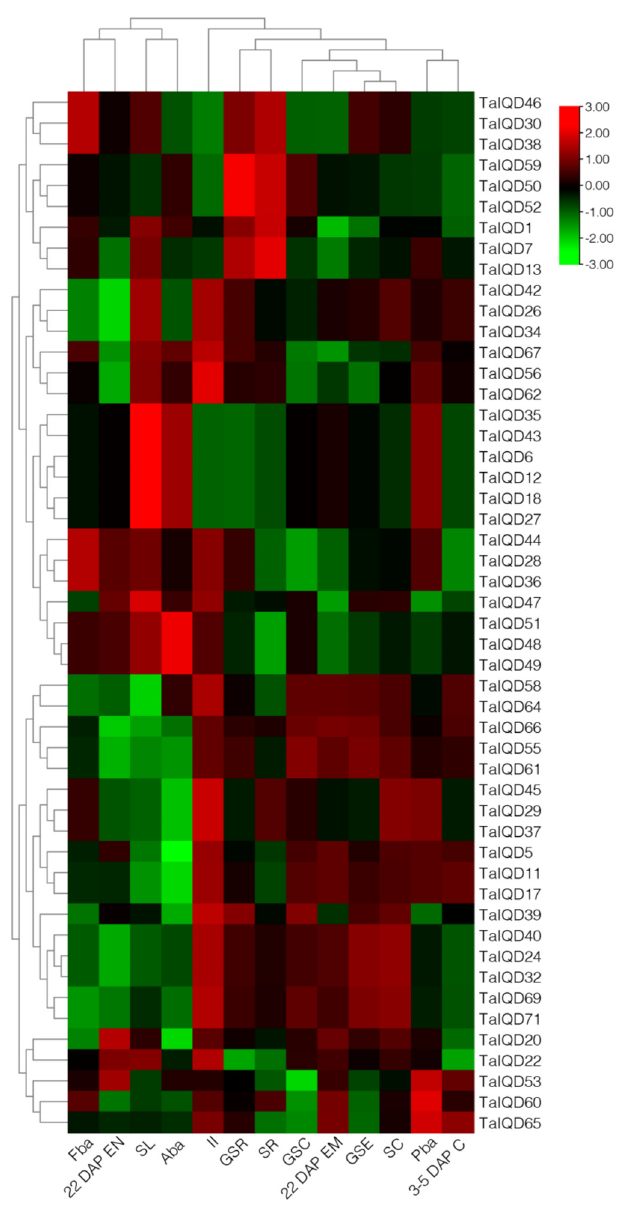
Figure 6. Expression profiles of TaIQD genes in different tissues and at different developmental stages. The heat map shows hierarchical clustering of the 50 TaIQD genes among different tissues. Abbreviations represent specific developmental stages: GSC, germinating seed, coleoptile; GSR, germinating seed, root; GSE, germinating seed, embryo; SR, seedling, root; SC, seedling, crown; SL, seedling, leaf; II, immature inflorescence; FBA, floral bracts, before anthesis; PBA, pistil, before anthesis; Aba, anthers, before anthesis; 3–5 DAP C, 3–5 DAP caryopsis; 22 DAP EM, 22 DAP embryo; 22 DAP EN, 22 DAP